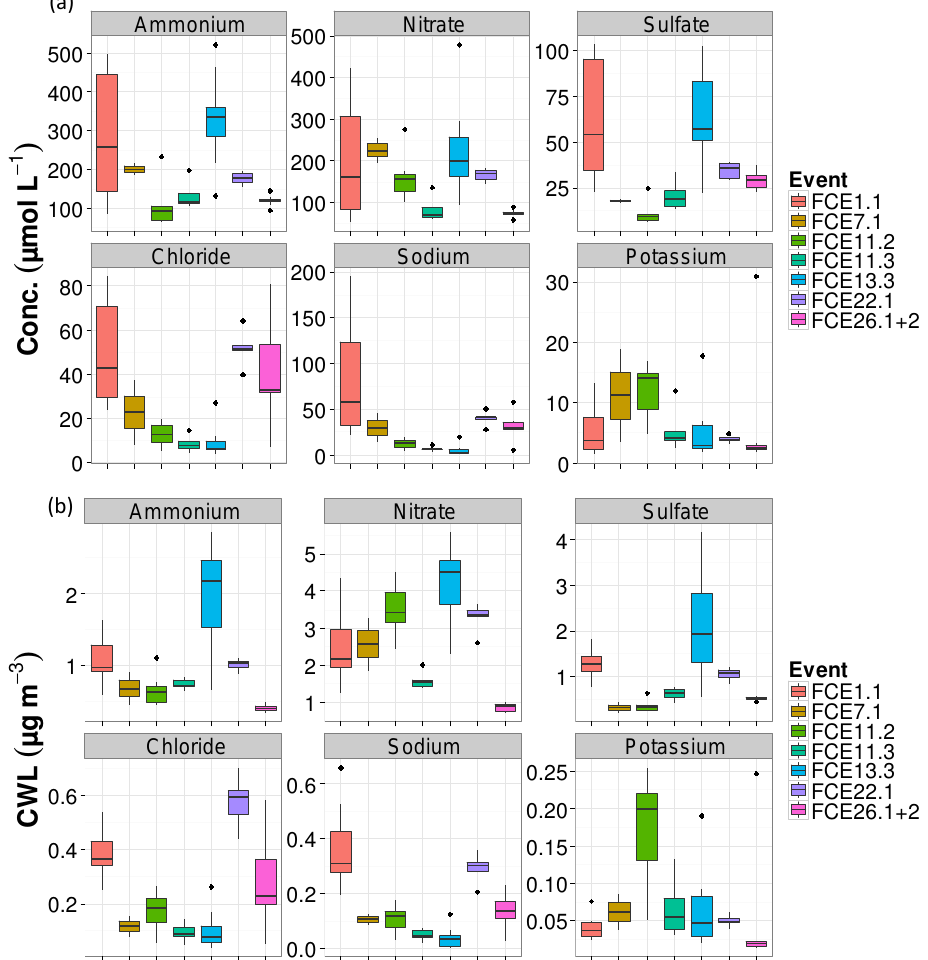
Figure 3. Variability of cloud water concentrations both within and between FCEs for selected inorganic ions. (a) Solute concentrations, (b) Cloud water loadings. Boxes indicate 25th, 50th, and 75th percentile, whiskers extend to 1.5 × IQR (interquartile range), and dots indicate individual data points outside this